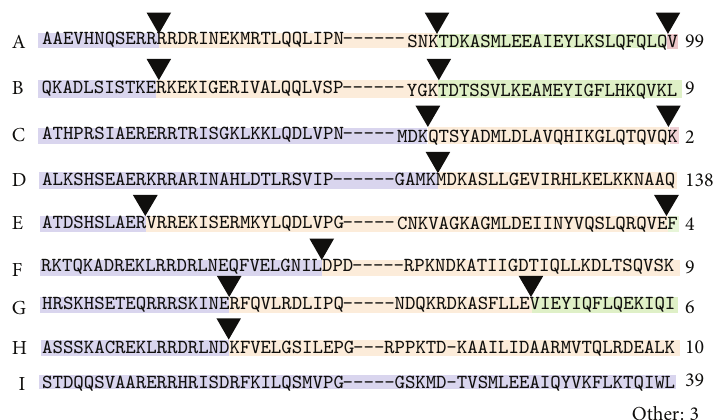
Figure 2: Conservationof intronposition withinthebHLH domain of soybean bHLH genes. Representative bHLH sequences areshown with the positions of three typical bHLH introns (pattern A) marked and the number of genes (99) that fit this pattern. Other bHLH genes have a subset of these three introns (patterns B–E). An alternative pattern F contains one intron at a different location. The genes with pattern G have two other conserved introns, and pattern H has only the first of these introns. 39 of the soybean bHLH genes have no introns within the bHLH domain. Three other bHLH genes exhibit a different intron-exon pattern. The specific domains shown are as follows (A–I): GmbHLH234, GmbHLH183, GmbHLH253, GmbHLH136, GmbHLH289, GmbHLH77, GmbHLH145, GmbHLH84, and GmbHLH98. Intron patterns for all soybean bHLHs are located in Additional File